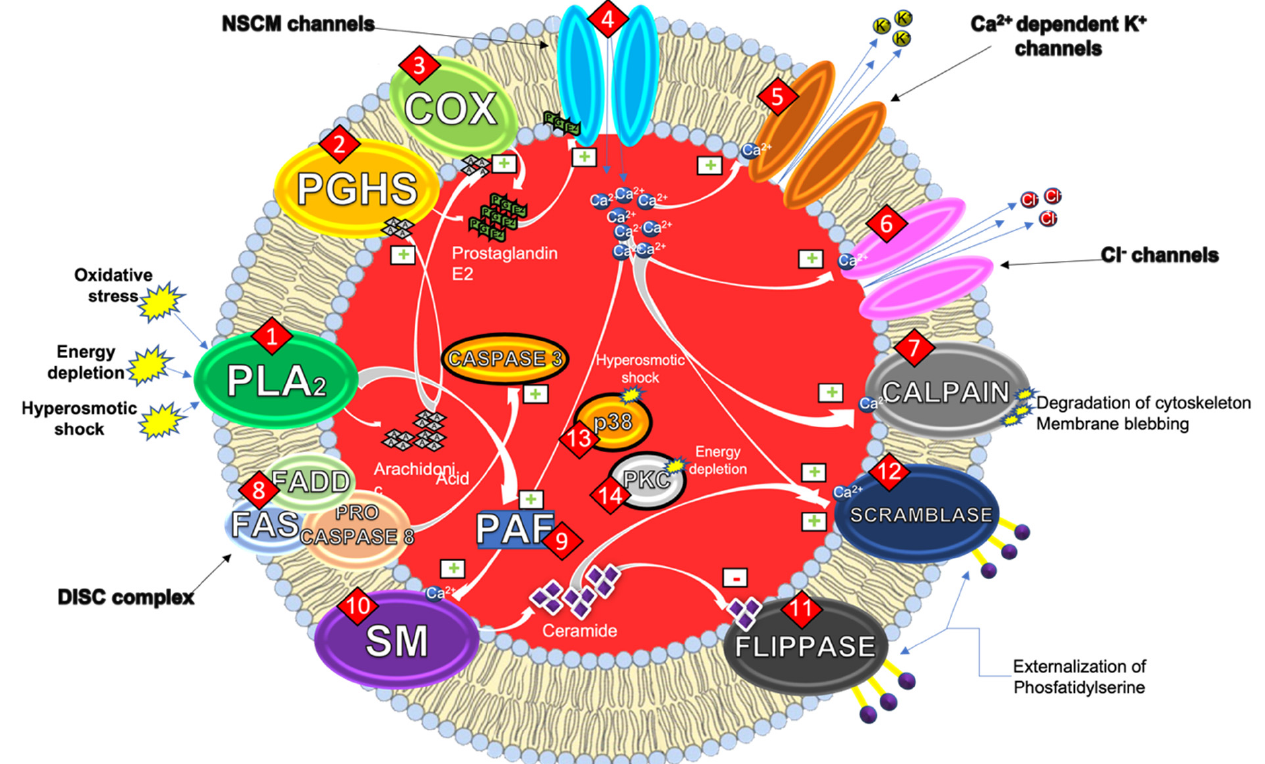
Figure 1. Biomolecular pathways that regulate the eryptosis machinery. The green plusses inside the rectangles indicate activation, the red minuses inside the rectangles indicate inhibition. The bold numbers inside the round brackets inserted in the text refer to the numbering of the detracted pathway in the figure. Modified version of figure present in [6].